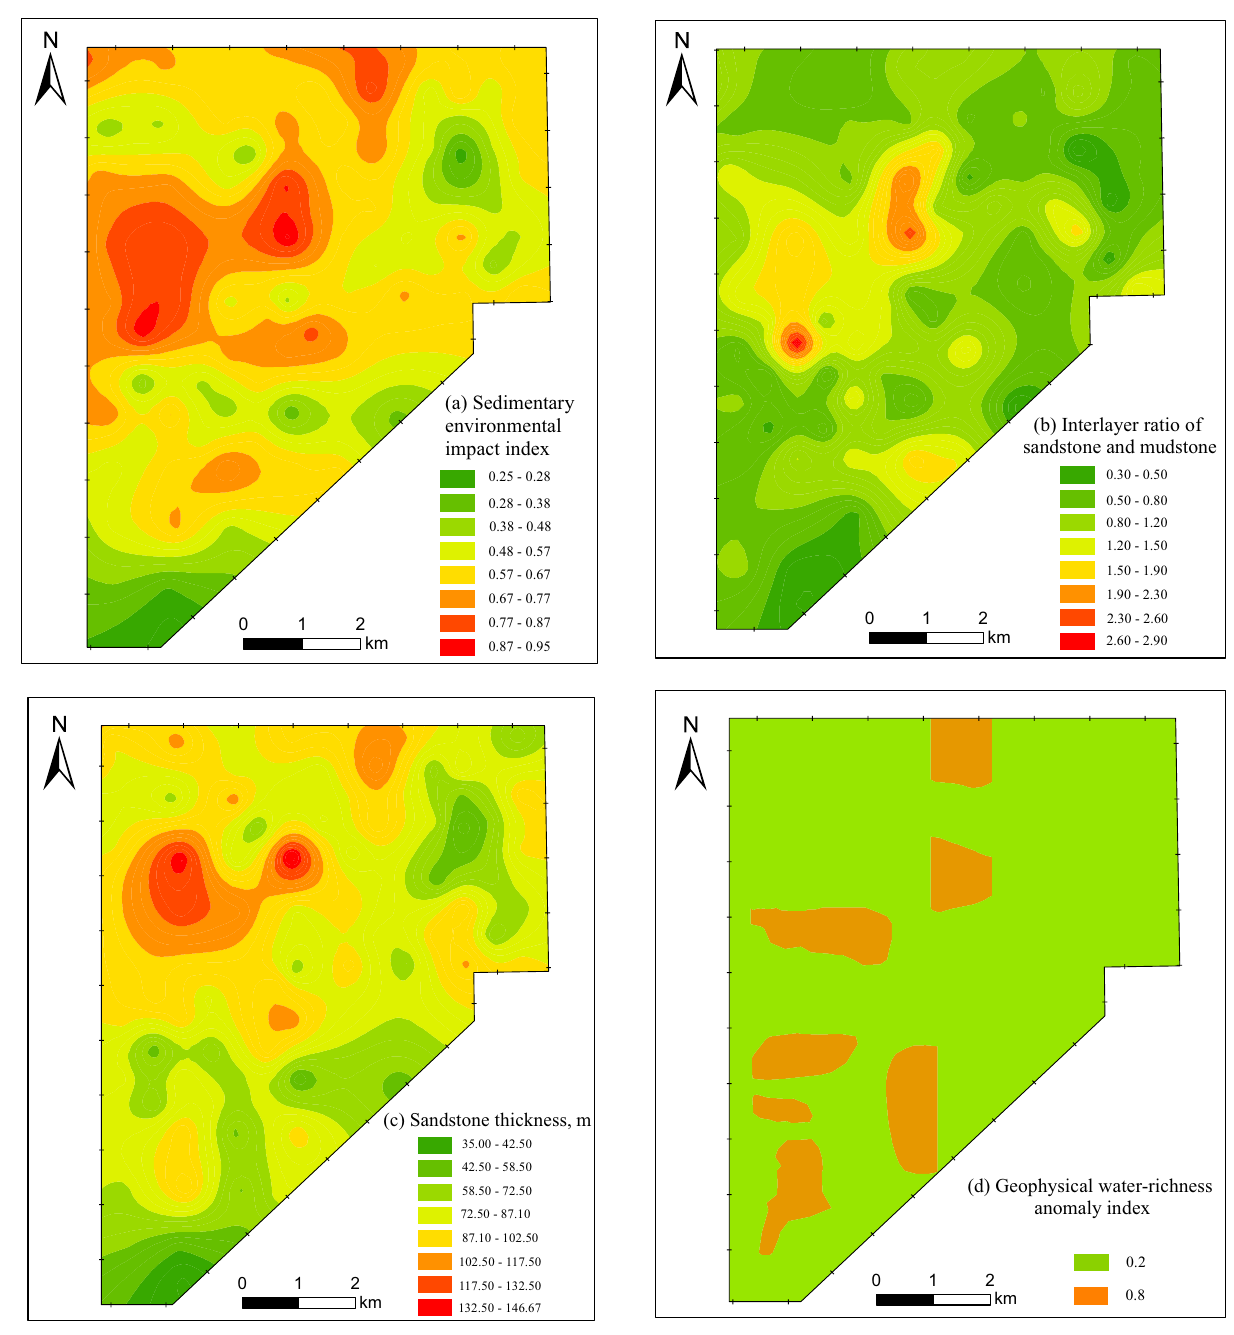
Figure 8. Thematic maps of the main controlling